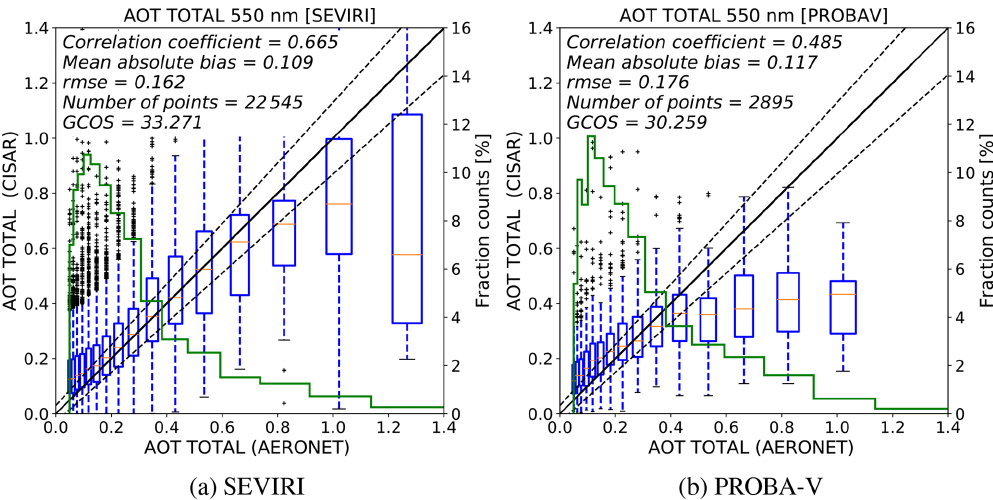
Figure 14. Box plots showing the CISAR AOT retrieval extrapolated at 0.55µm (left y axis) against the AERONET data ( x axis) for SEVIRI ( a ) and PROBA-V ( b ) over all the selected stations. Only retrievals with QI ≥ 0 . 2 are considered. The blue boxes represent the interquartile range (IQR), the red horizontal line represents the median value, the vertical dashed bars represent the 1 . 5 × IQR range and the black crosses represent the outliers. Boxes with fewer than 10 points are not displayed. The green histograms represent the AERONET AOT distribution. The right y axis shows the percentage of points contained in each